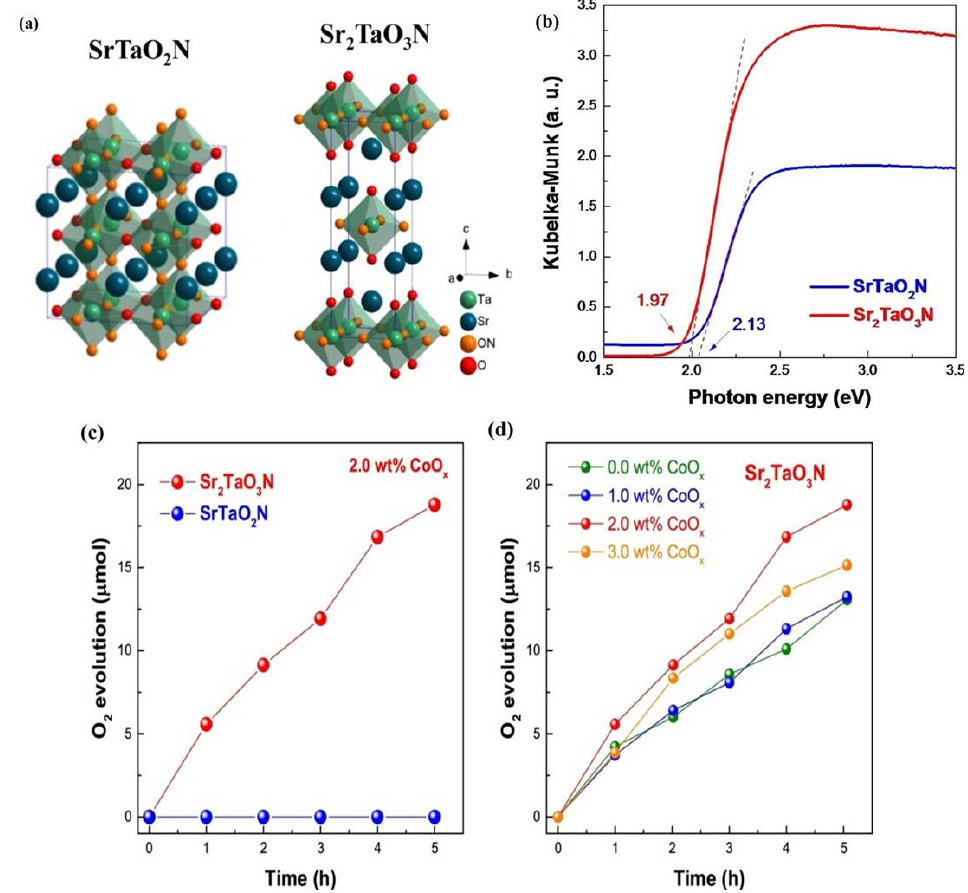
Figure 6. ( a ) Atomic arrangement of the Sr 2 TaO 3 N and Sr 2 TaO 2 N photocatalyst; ( b ) band gap energy of both photocatalyst; ( c ) oxygen evolution rate of SrTaO 2 N and Sr 2 TaO 3 N when loaded with 2.0 wt% CoO x under visible light; ( d ) oxygen evolution rate of Sr 2 TaO 3 N with various percentage of CoO x co-catalyst in the presence of AgNO 3 . Reproduced with permission, [90] Copyright 2018, Elsevier. Table 1. List of few reported oxynitride photocatalysts, their crystal structure, band gap, and amount of H 2 and O 2